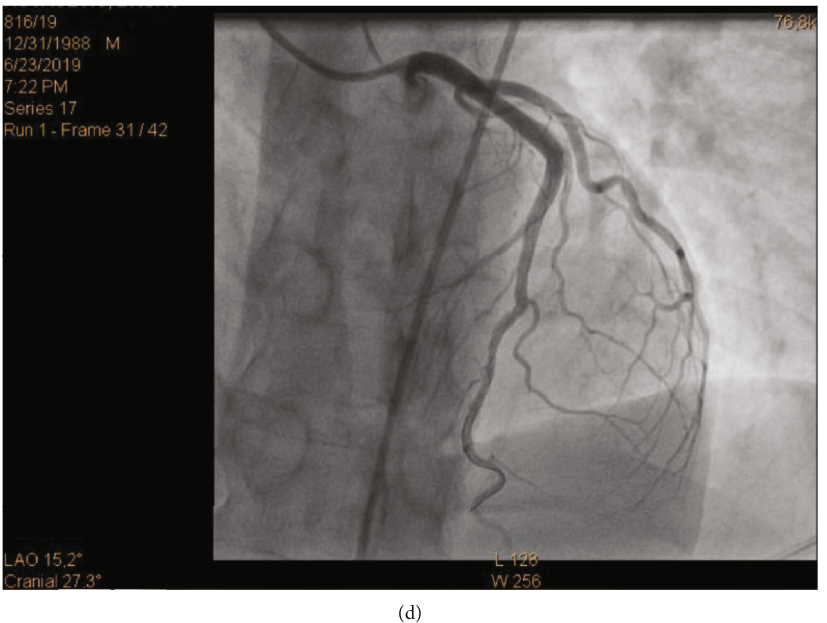
Figure 2: (a) Left anterior descending artery — proximal segment subocclusion. (b) Left anterior descending artery — RAO. (c) Right coronary